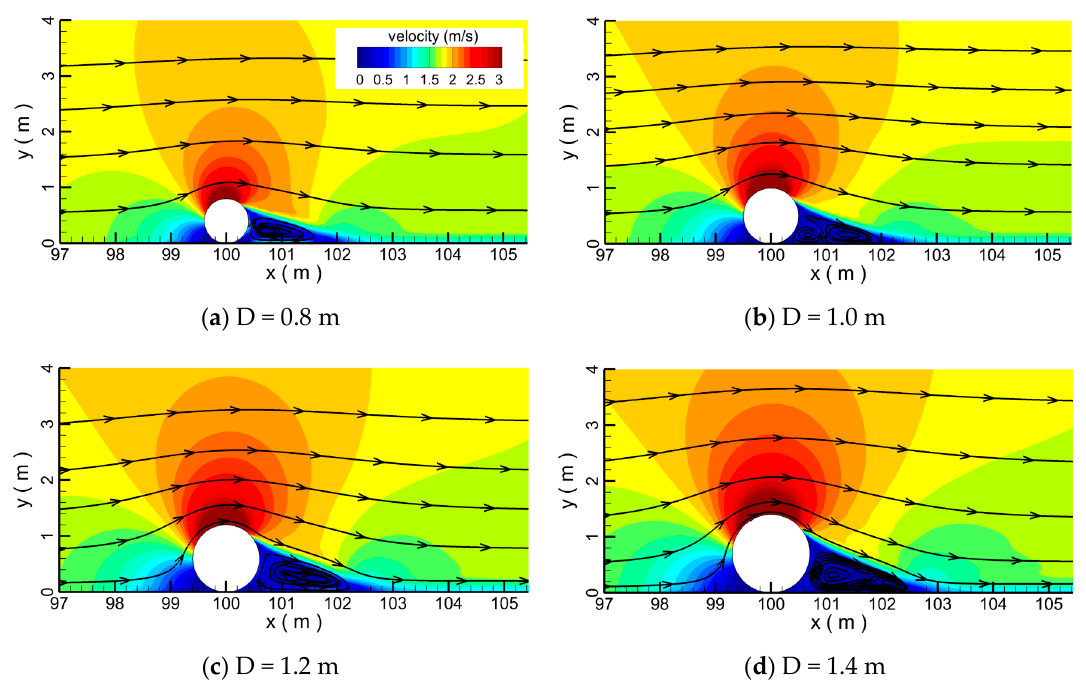
Figure 23. The velocity contours of flow fields around different size pipelines. Water 2018 , 10 , x